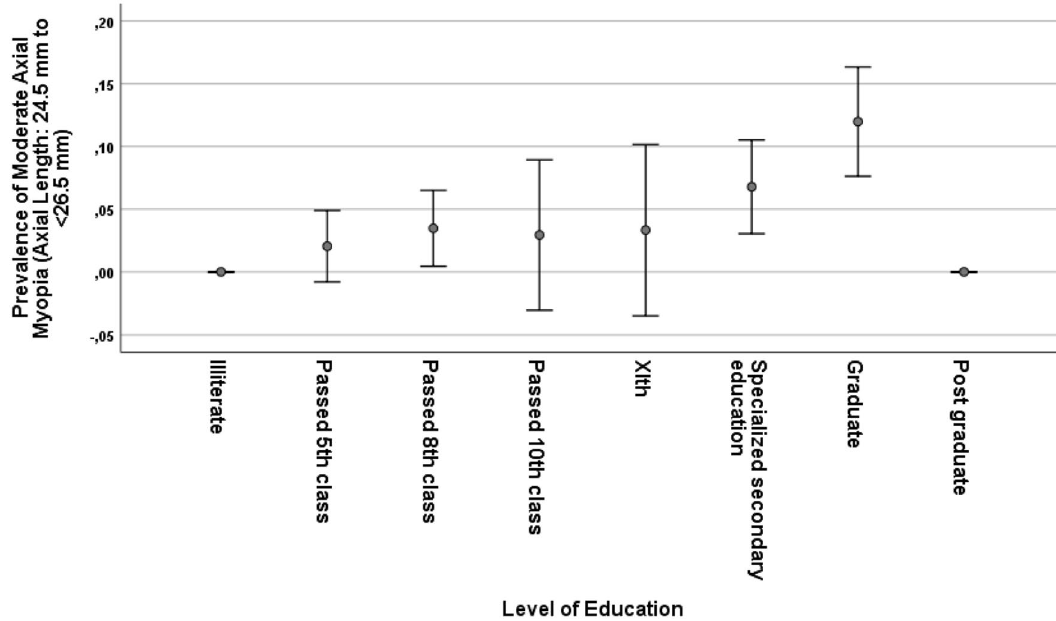
Figure 3. Graph showing the distribution of the prevalence of moderate myopia (axial length 24.5 mm to < 26.5 mm) in the Ural Very Old, stratified by the level of education.